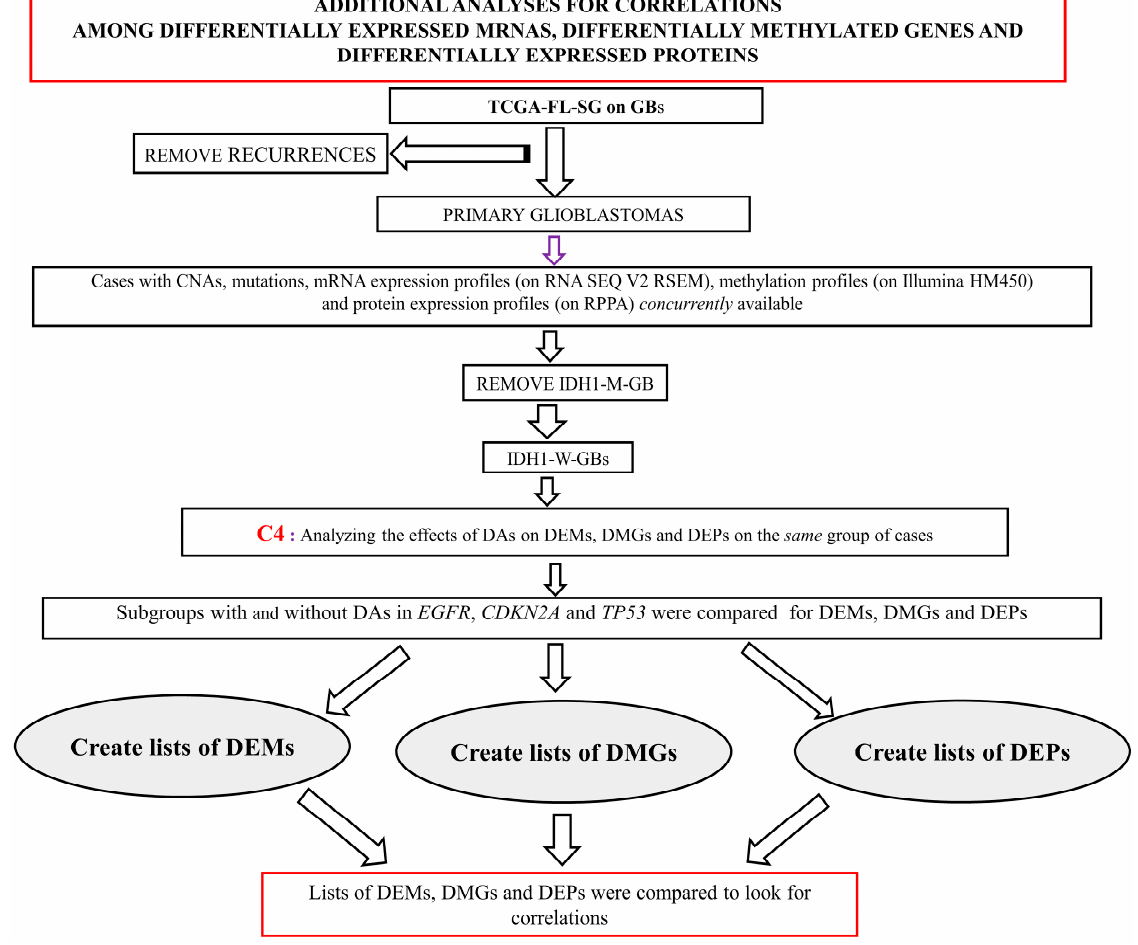
Figure 2. Workflow of the additional analyses performed on the C4 group where CNAs, mutations, mRNA expression profiles (on RNA SEQ V2 RSEM), methylation profiles (on Illumina HM450) and protein expression profiles (on RPPA) were concurrently available to determine correlations among DEMs, DMGs and DEPs. TCGA-FL-SG: The Cancer Genome Atlas Study Group; GBs: Glioblastomas; IDH1-M-GB: IDH1 mutant glioblastoma; IDH1-W-GB: IDH1 wildtype glioblastoma; DA: Driver alteration; CNA: Copy number alteration; DEM: Differentially expressed mRNAs; DMG: Differentially methylated genes; DEP: Differentially expressed proteins; RNA seq v2 RSEM: RNA sequencing platform V2 and analyzed with RNA sequencing by Expectation Maximization (RSEM) software package.